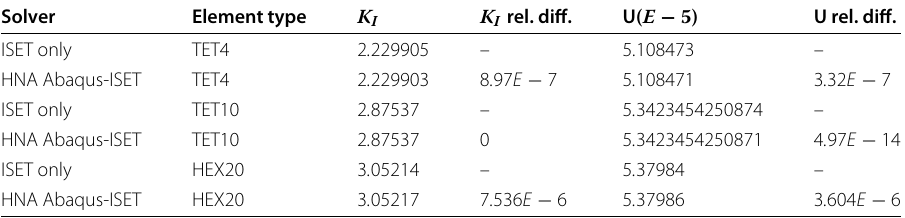
Table 1 Strain energy ( U ) and mode I stress intensity factor ( K I ) computed with HNA Abaqus-ISET and ISET only Solver Element type K I K I rel.